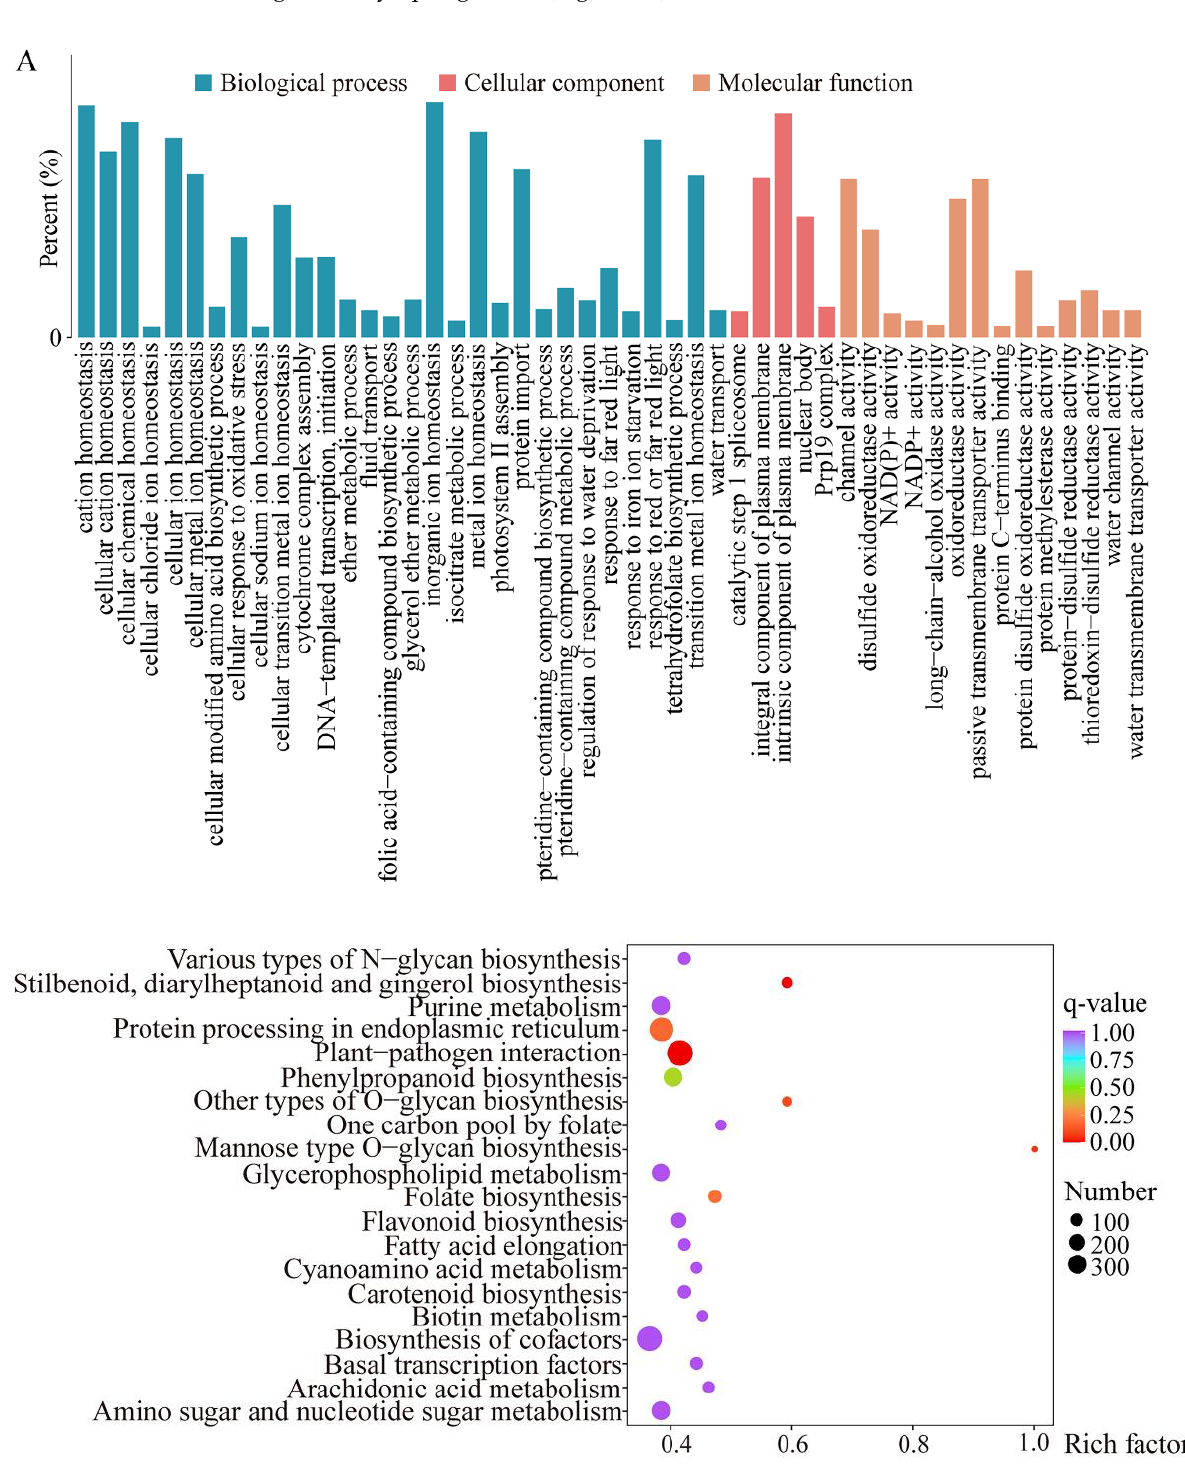
Figure 2. Functional annotation of the cis-target genes of DELs. ( A ) GO enrichment analysis of the cis-target genes of DELs. ( B ) KEGG pathway enrichment of the cis-target gene of DELs. Rich factor represents the ratio of the number of the target gene of DELs to the total number of annotated genes in this pathway.